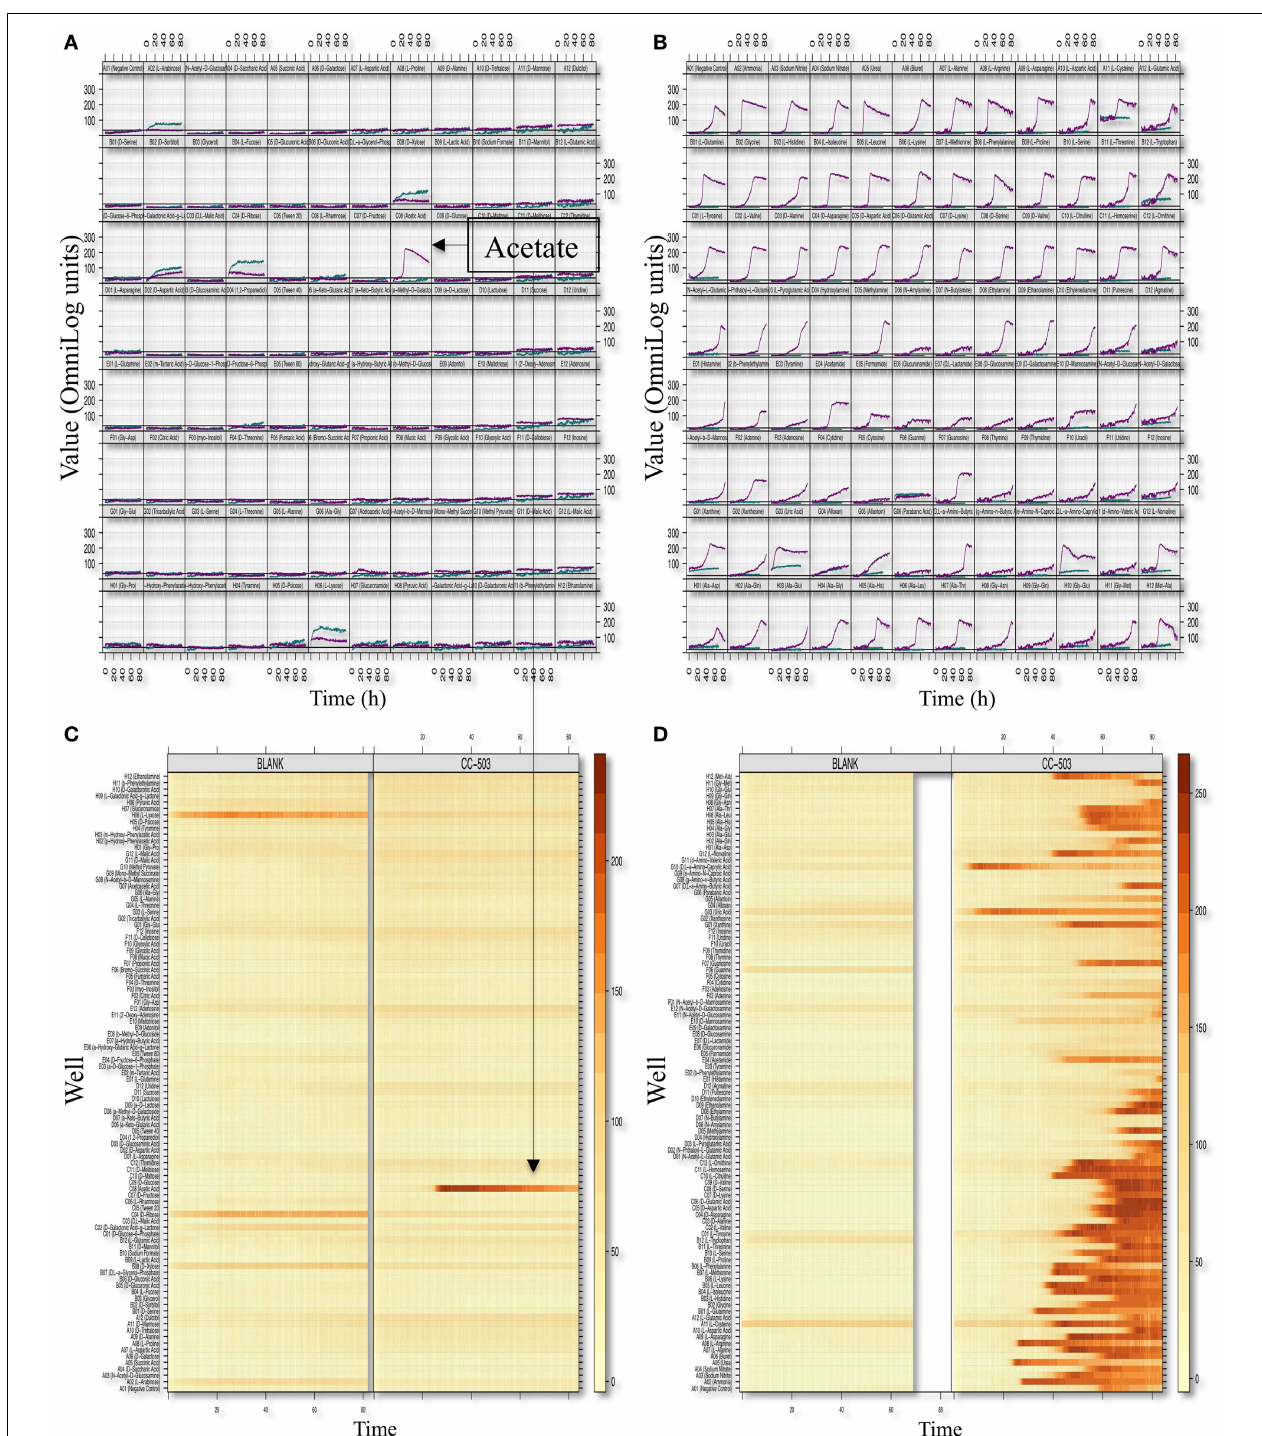
each cell and are indicated by color (teal color represents blank and purple color represents CC-503).The level-plot represents each respiration curve as a thin horizontal line changing color (or remaining unchanged) over time. Shading color changes from light yellow to dark orange or brownish based on the level of respiration measurement values, with the brownish color representing higher respiration values. Metabolites utilized by C. reinhardtii (CC-503) and the blank plates are